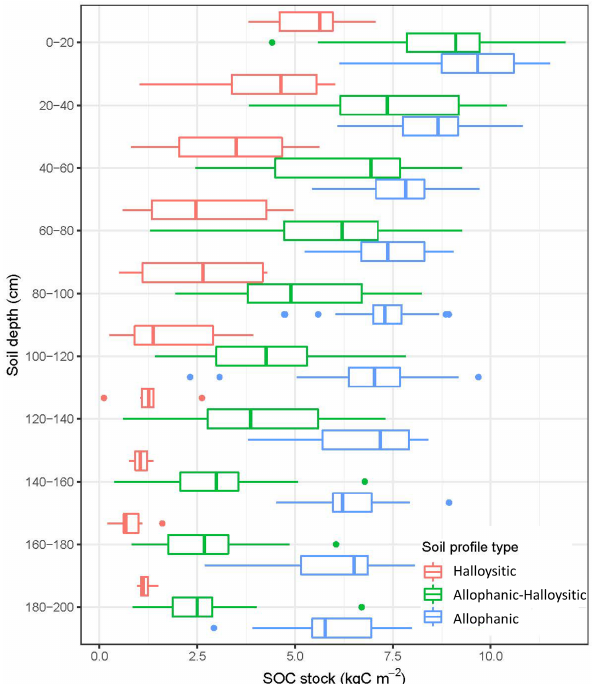
Figure 7. Mean SOC stocks in the three types of soil profiles. The allophanic profile is the mean profile of the 35 soil profiles composed of samples only in the allophanic spectral cluster; the halloysitic profile is the mean of the 8 soil profiles composed of samples only in the halloysitic spectral cluster; and the allophanic – halloysitic profile is the mean of the 26 soil profiles composed of samples in both spectral